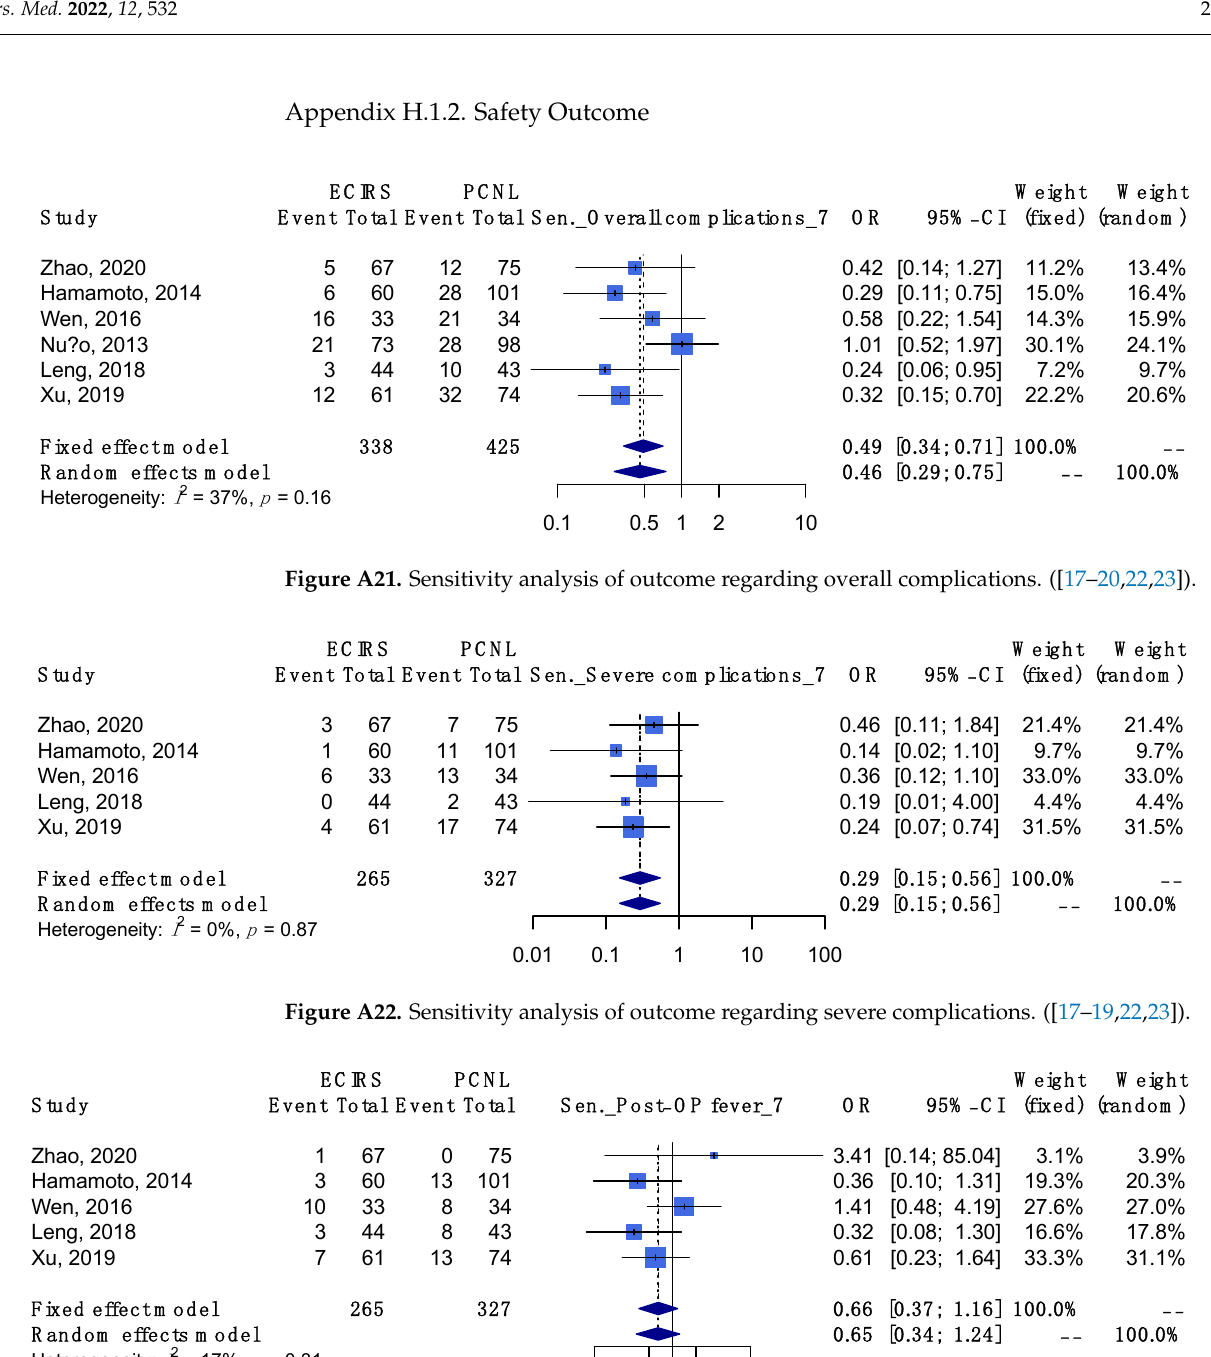
Figure A20. Sensitivity analysis of outcome regarding final stone free rate. ([17,19,20,22,23])